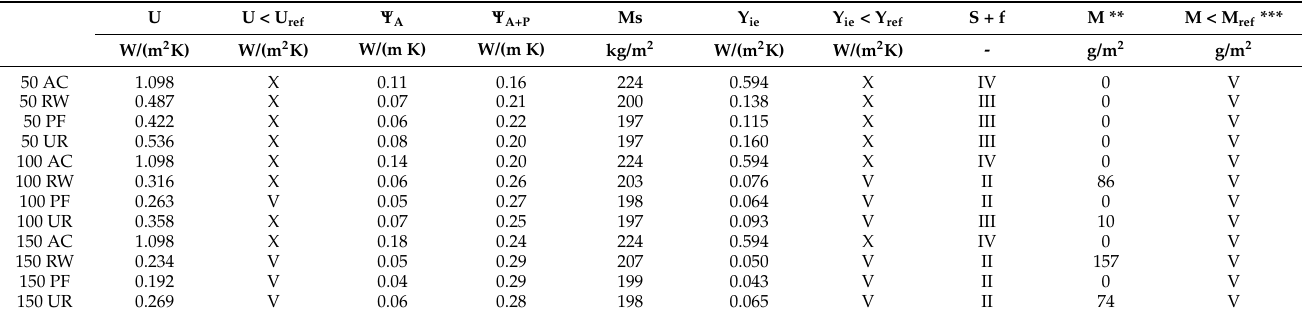
Table 9. Summary of the main results—cavity insulation and external plaster